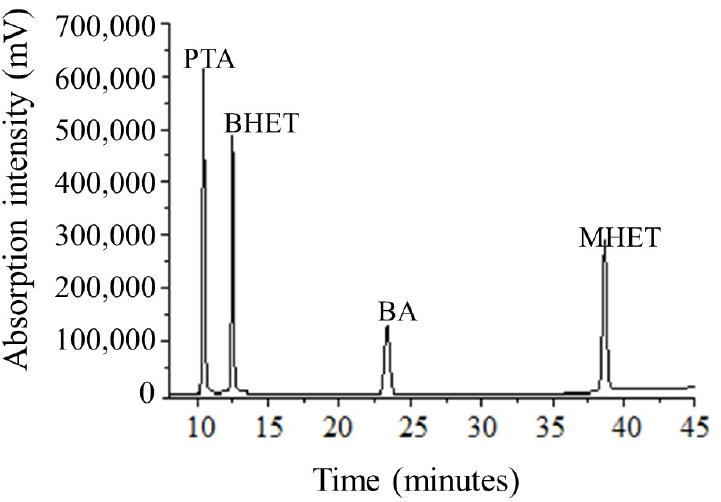
Figure 4. Chromatogram of terephthalic acid (PTA), bis(2-hydroxyethyl) terephthalate (BHET), benzoic acid (BA), and 2-hydroxyethyl methyl terephthalate (MHET) analytes (standard solutions 240 ppm, injection volume = 3 µL).